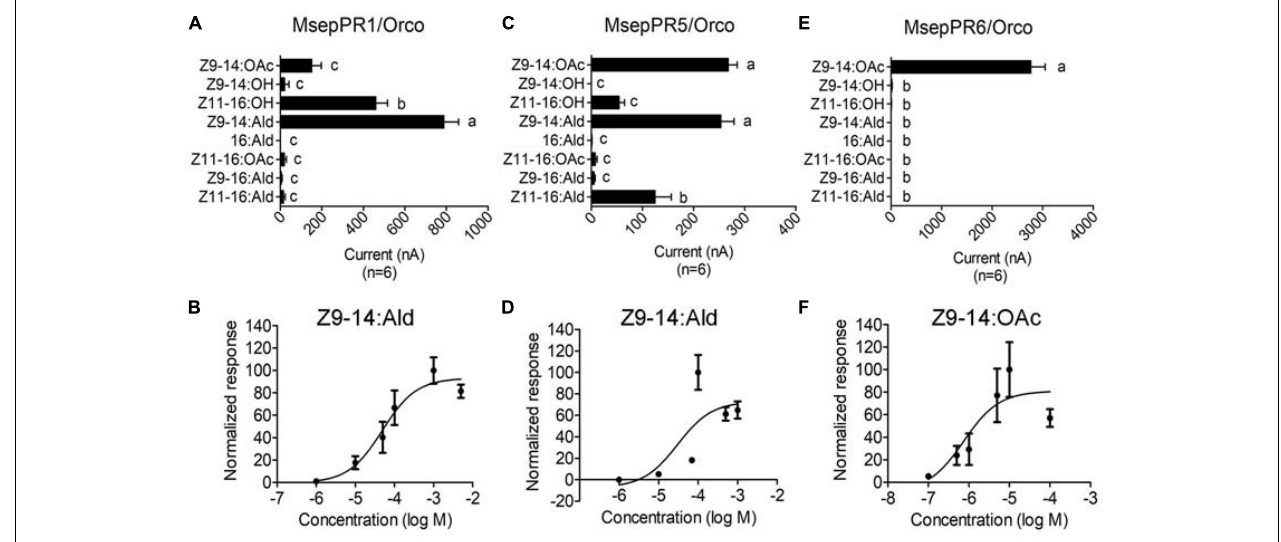
FIGURE 5 | Response profiles of MsepPR1/Orco, MsepPR5/Orco, and MsepPR6/Orco to four sex pheromone components and four pheromone analogs in Xenopus oocyte system. (A,C,E) Response profiles of MsepPR1/Orco, MsepPR5/Orco, and MsepPR6/Orco in response to 10 − 4 M solution of stimuli. Error bars indicate mean ± SEM ( n = 6). Comparisons between groups were made using ANOVA followed by LSD’s test. Different letters above the error bars indicated significant difference at the 0.05 level. (B) Dose-response curves of MsepPR1/Orco expressed in Xenopus oocyte to Z9–14:Ald. EC 50 = 4.90 × 10 − 5 M. Error bars indicate mean ± SEM ( n = 10). (D) Dose-response curves of MsepPR5/Orco to Z9–14:Ald. EC 50 = 3.04 × 10 − 5 M. Error bars indicate mean ± SEM ( n = 5). (F) Dose-response curves of MsepPR6/Orco to Z9–14:OAc. EC 50 = 7.46 × 10 − 7 M. Error bars indicate mean ± SEM ( n = 8). Responses are normalized by defining the average response as